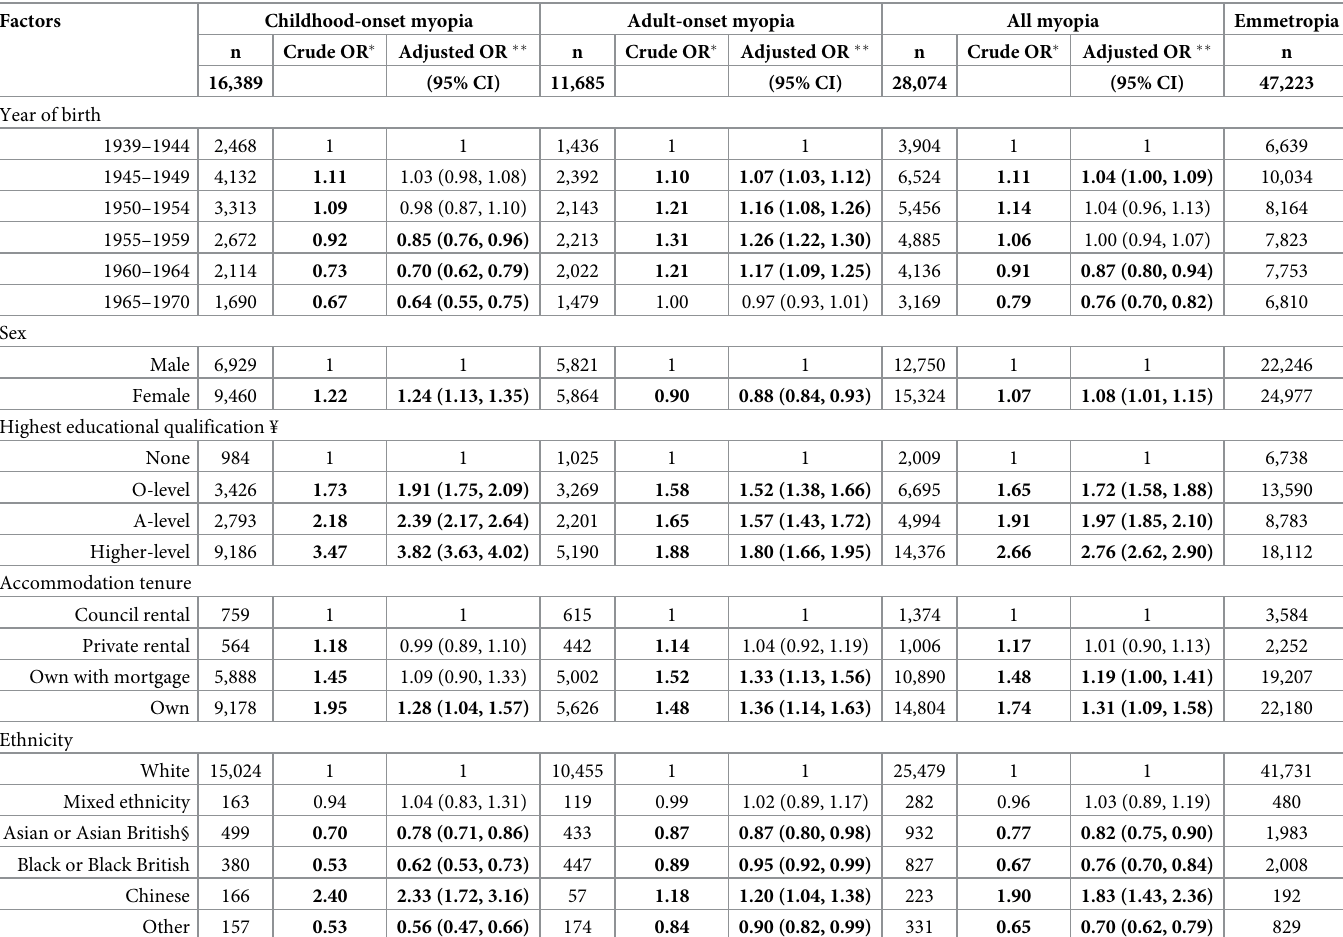
Table 2. Association of myopia (all, childhood-onset and adult-onset), with socio-demographic and environmental factors in 75,297 participants.